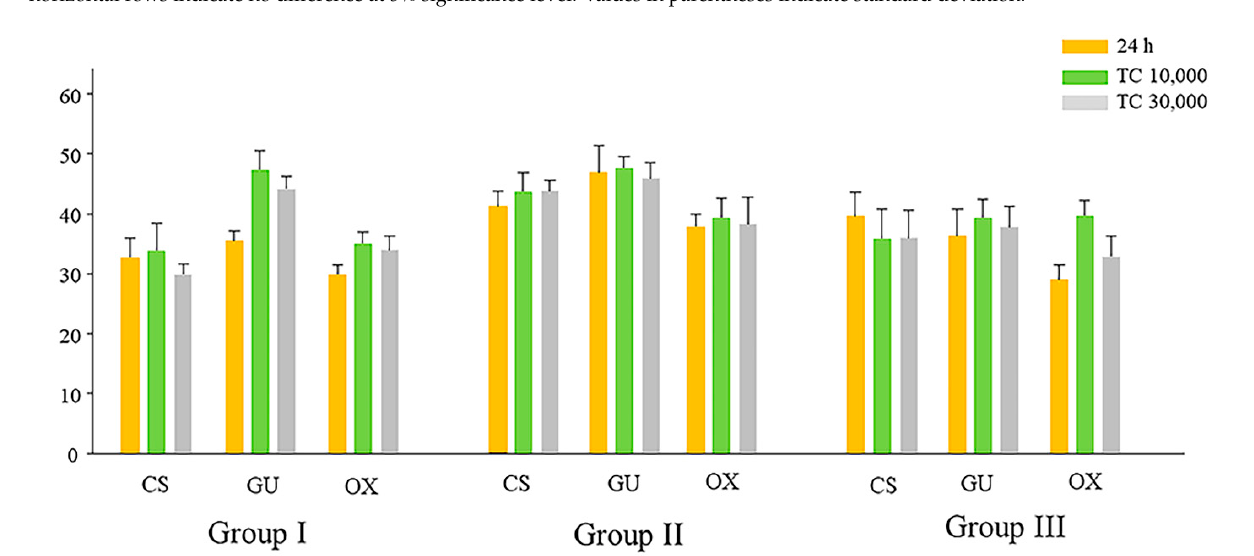
Table 3. Influence of application method on enamel bond strength (SE mode).